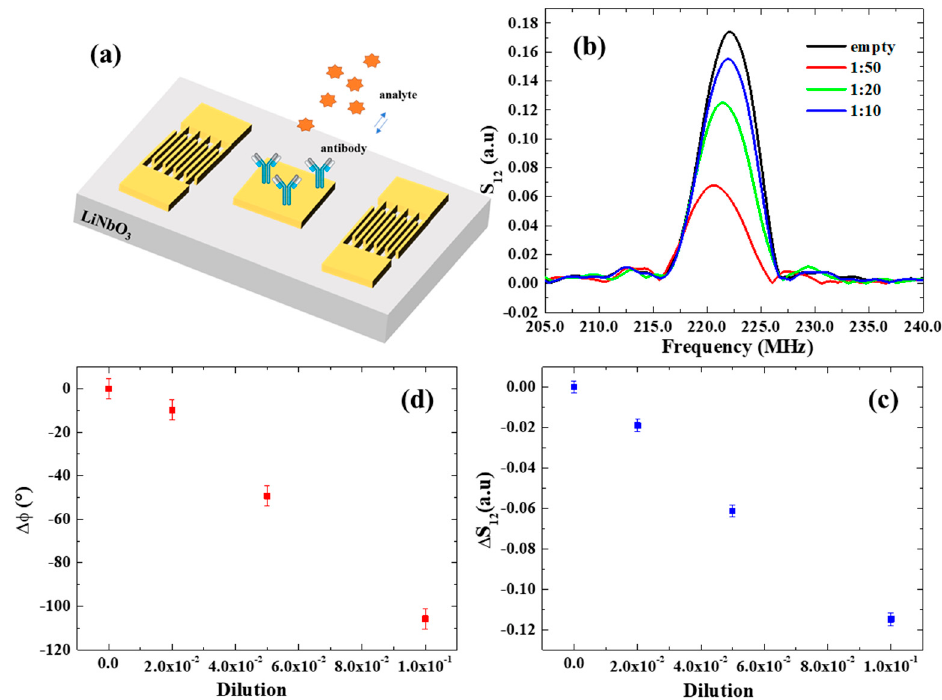
Figure 4. (a) Schematic illustration of a SAW device and electrode functionalization. (b) S 12 spectrum in response to serial dilutions of GLRaV-3 virus source homogenate. (c–d) Transmitted signal vari- ation and phase shifts as a function of dilution of GLRaV-3 virus source